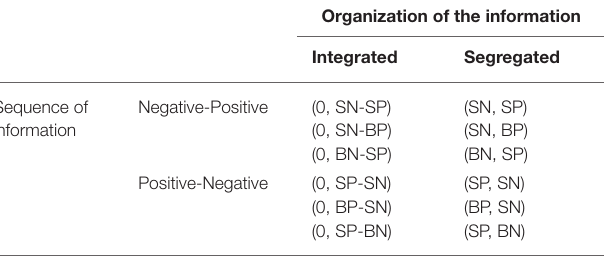
TABLE 1 | Experiment design is listed for all three groups of information: SP/SN; BP/SN;